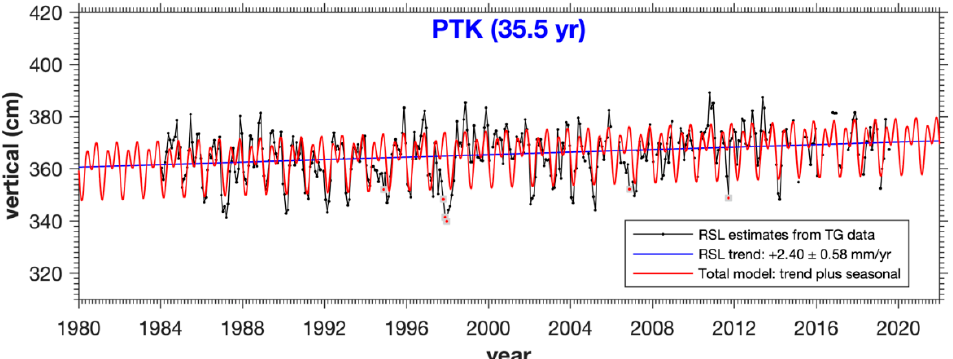
Figure 7. Trend and annual and semi-annual estimates from the monthly tide gauge data at Port Klang station.